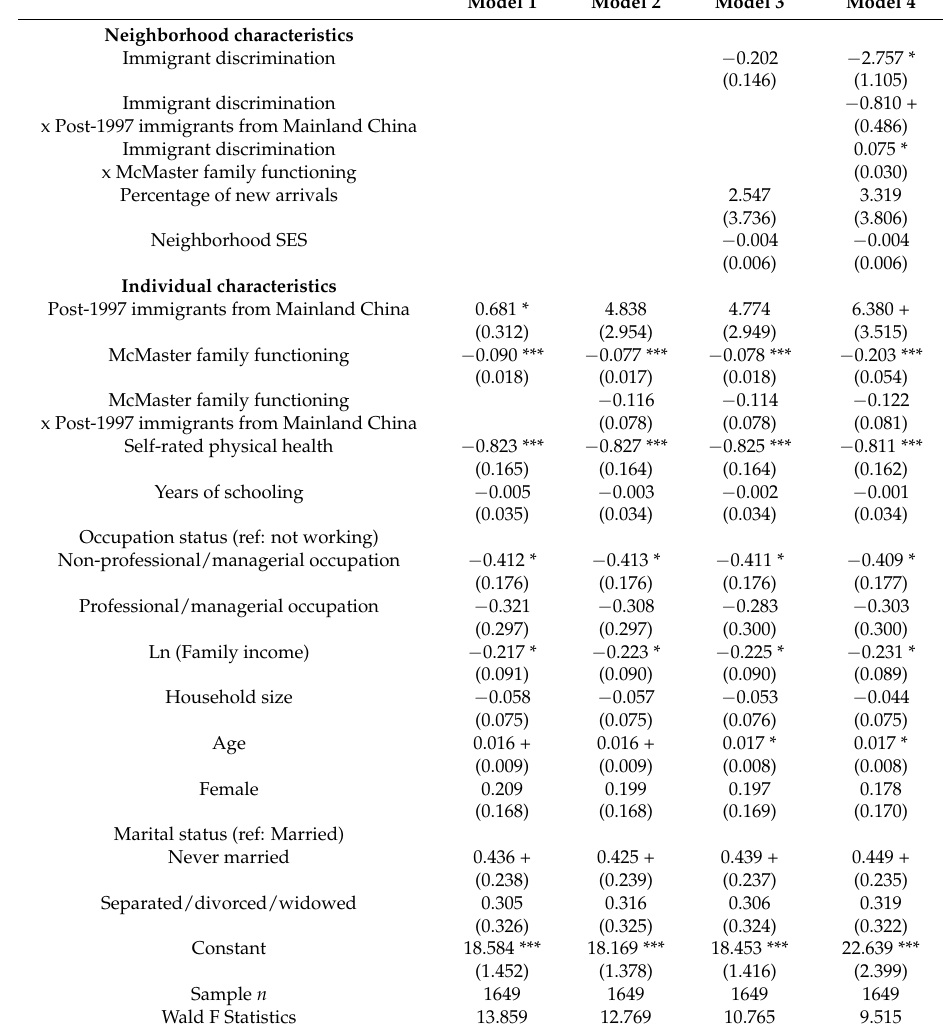
Table 2. OLS Estimating Association between Immigrant Discrimination and HSCL Psychological Distress among Public Housing Residents with